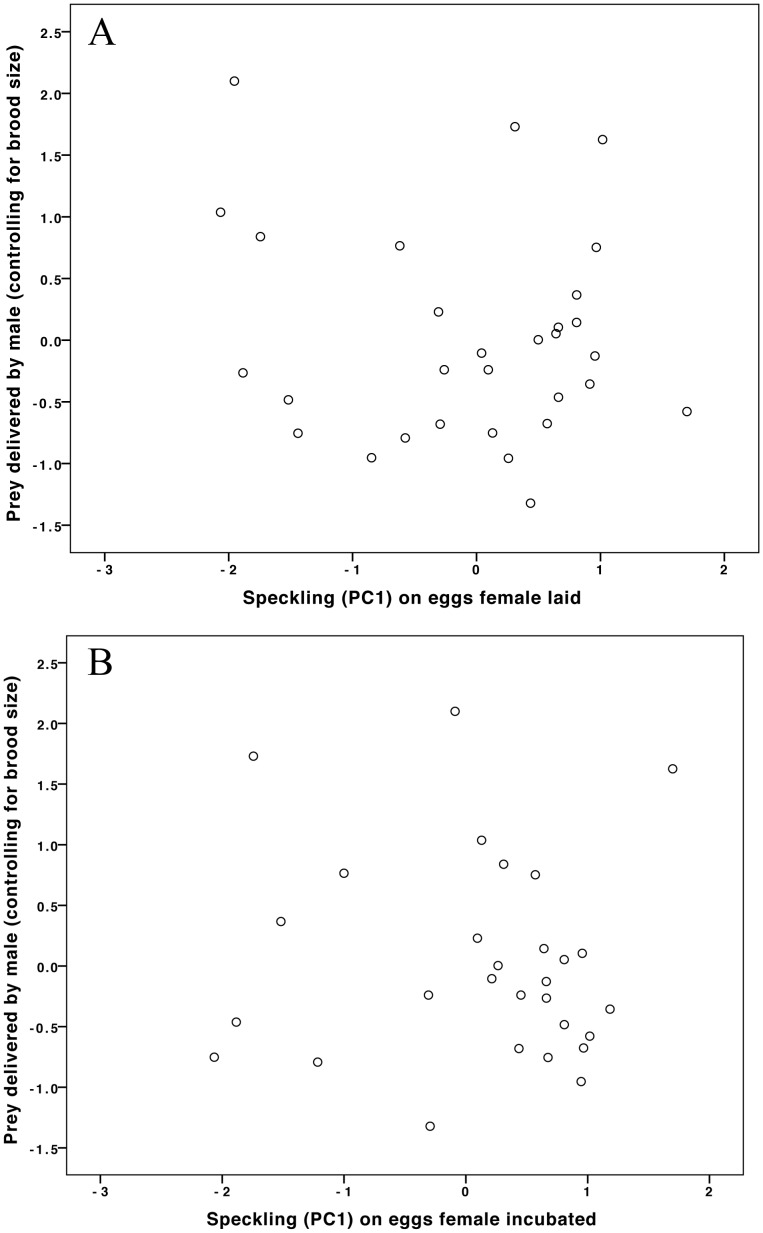
The amount of prey delivered by males was not related to egg speckling on the eggs (A) that his partner laid or (B) that he saw (his partner incubated).N = 29 nests. Brood size is controlled for by using the residuals of prey delivered by males over brood size on the y-axis.